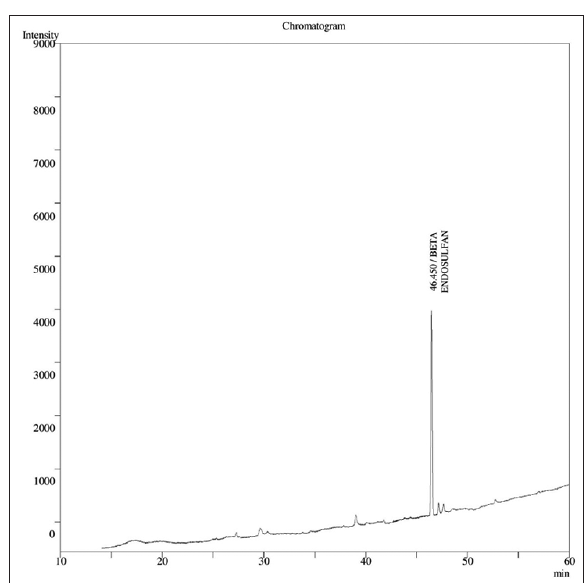
Figure-1: Chromatogram representing elution pattern of beta endosulfan standard.